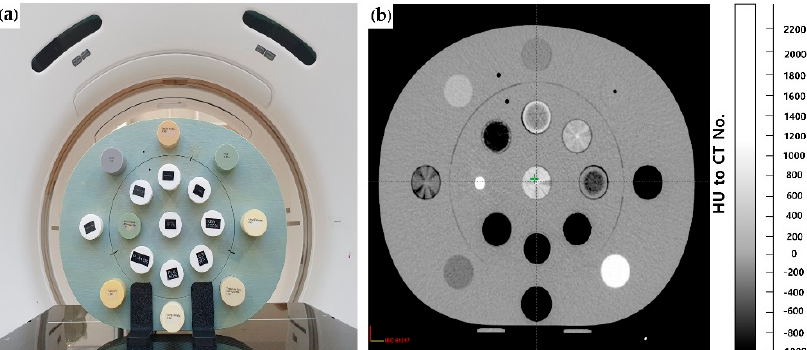
Figure 2. Electron density analysis of 3D printing materials using kVCT. ( a ) 3D printing material (white insert with black label) produced in this study and insert material with well-known electron density from CIRS. ( b ) Phantom image with electron density obtained using kVCT (0 HU: water density, negative HU: material with less density than water, positive HU: material with more density than